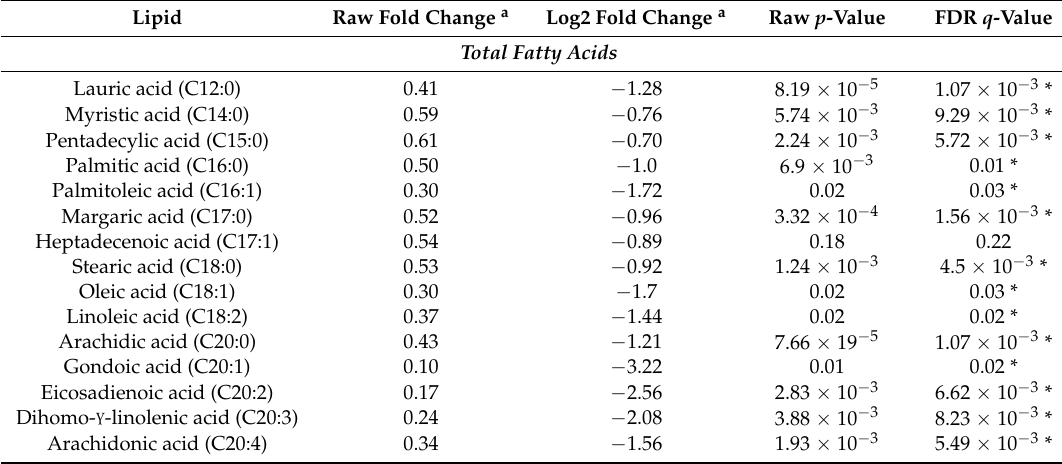
Table 2. Lipidomic species